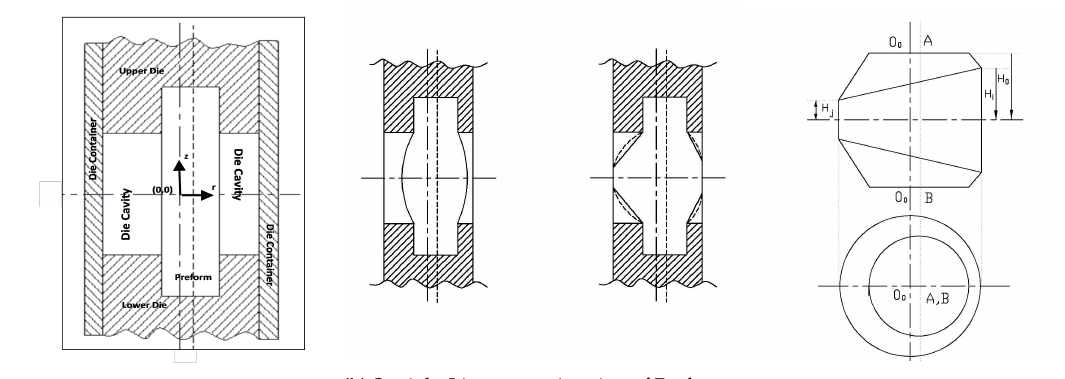
Fig. 2. Closed-Die Forging of Eccentrically-Located AMC Preform.